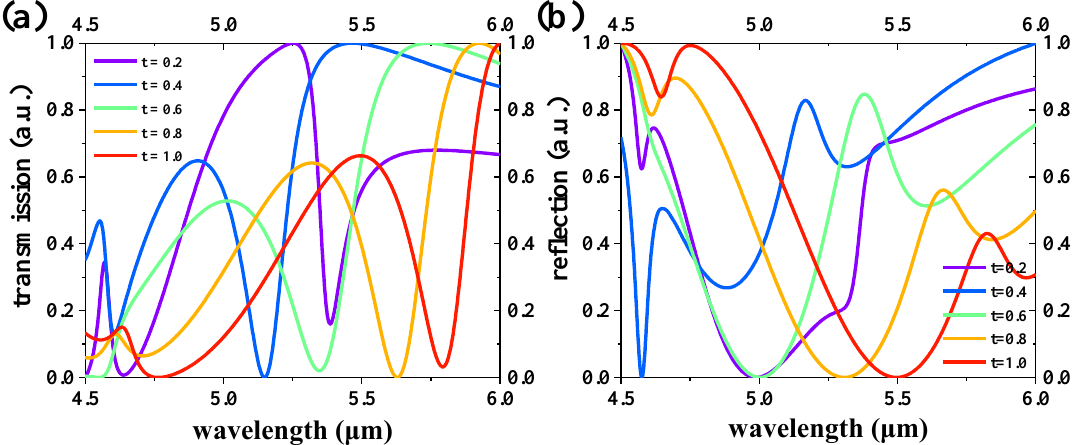
Figure 2. ( a ) Transmission and ( b ) reflection spectra of CSM with different t values under the condition of L = L 1 = L 2 .